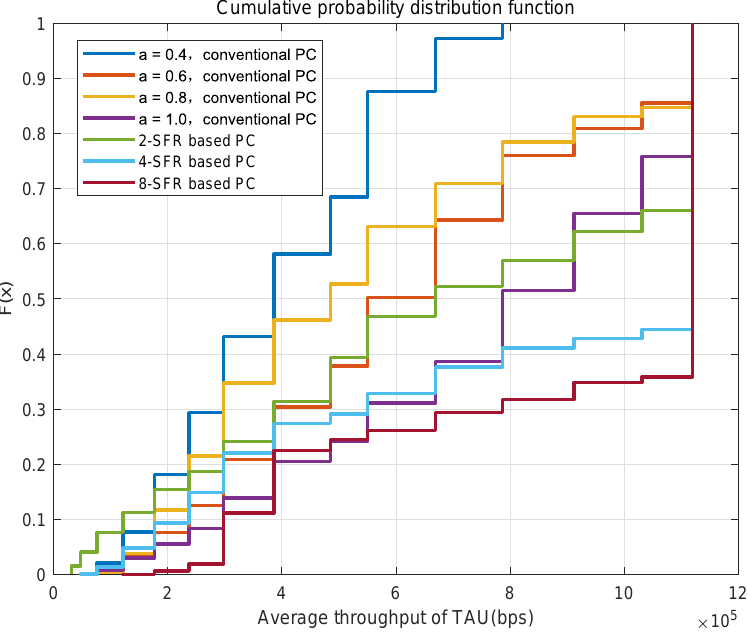
Figure 8. CDF of the throughput in different power control schemes.